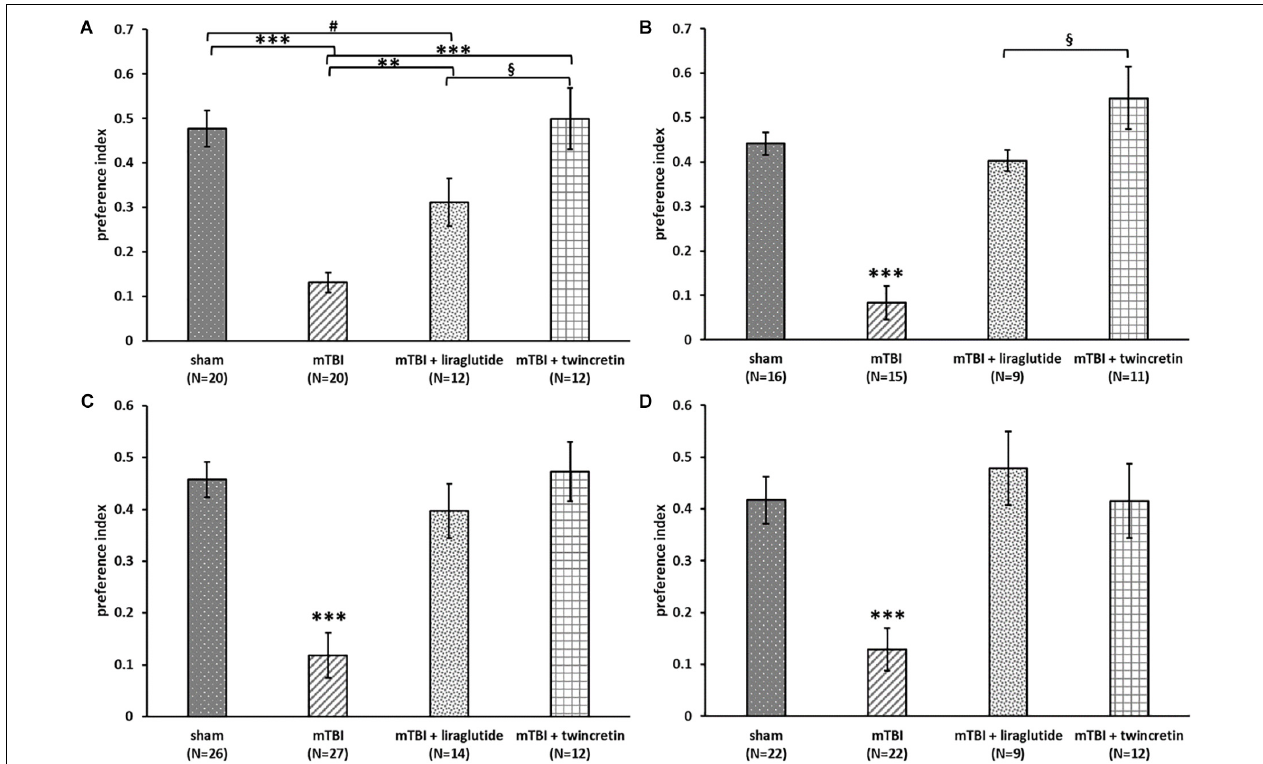
FIGURE 3 | Liraglutide and twincretin treatments lead to improvement in mTBI-induced cognitive impairments at both 7 and 30 days post trauma. Visual memory was assessed using the novel object recognition (NOR) paradigm at 7 days (A) and 30 days (B) post injury. Preference index was used to represent the relative time that animals spend exploring a novel object compared to a familiar one, which reflects visual memory. One-way ANOVA test followed by Fisher’s LSD post hoc analysis revealed that the preference index of mTBI group was significantly lower than all other groups at both time points [ A: F (3,60) = 17.135; p < 0.001 and B: F (3,47) = 23.22; p < 0.001, ∗∗ p < 0.01, ∗∗∗ p < 0.001). The preference index of the liraglutide treated group was significantly lower than sham and twincretin treated group at 7 days (# p < 0.05 vs. sham and § p < 0.05 vs. mTBI + liraglutide), while only lower than twincretin treated group at 30 days (§ p < 0.05 vs. mTBI + liraglutide). Values are mean ± SEM. Spatial memory was evaluated using the Y-maze paradigm at 7 (C) and 30 days (D) post injury. Preference index was used to represent the relative time that animals spent exploring a novel arm of the maze compared to a familiar one, reflecting spatial memory. One-way ANOVA followed by Fisher’s LSD post hoc analysis revealed that the preference index of mTBI group was significantly lower than all other groups at both time points [ C: F (3,75) = 15.851; p < 0.001 and D: F (3,61) = 9.811; p < 0.001, ∗∗∗ p < 0.001]. Treatment with either liraglutide or twincretin led to similar normalization. Values are mean ±